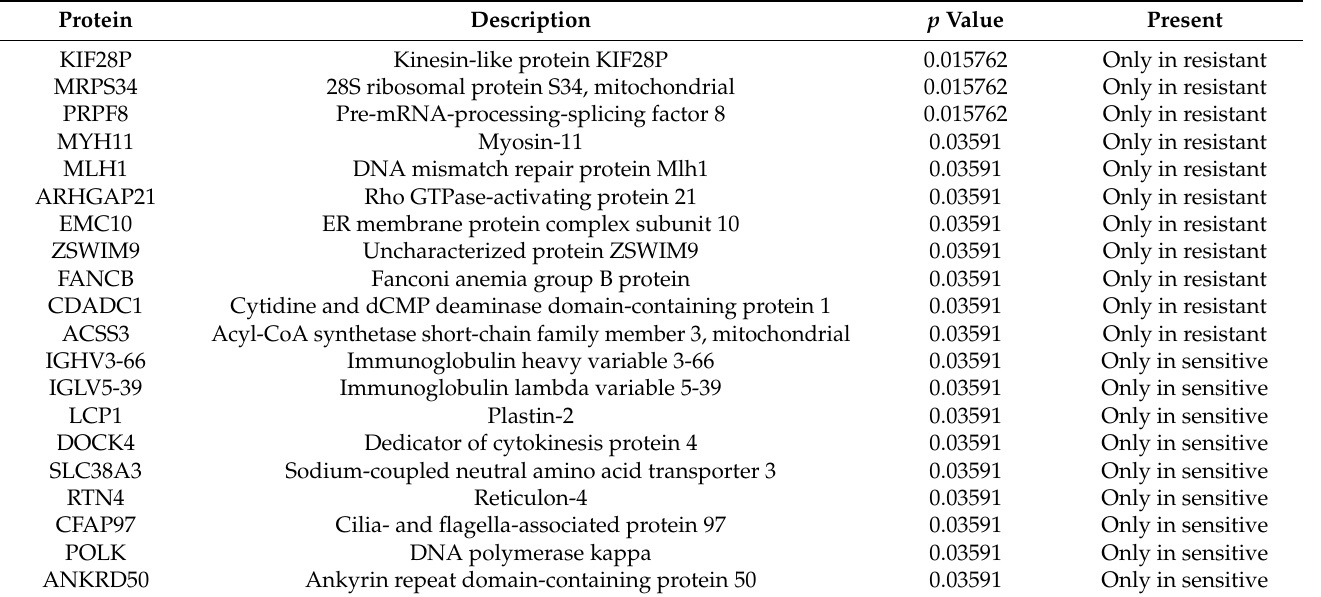
Figure 1. Heatmap ( left ) and Volcano plot ( right ) of proteins quantified in patients with complete (hypersensitive) or not complete (resistant) response to cortisol. Heatmap shows the abundance of proteins passing the ±0.585 log2 fold change threshold, in the two groups. Volcano plot includes proteins with presence in at least 35% of the analyzed samples (in one of the two groups) and illustrates the log2 fold change (x axis) as a function of the Mann – Whitney p value (y axis). Red color marks proteins passing the 1.5 (or 0.67)-fold change (equivalent to ±0.585 in the logarithmic scale). Table 3. Proteins being exclusively present in one of the two groups.